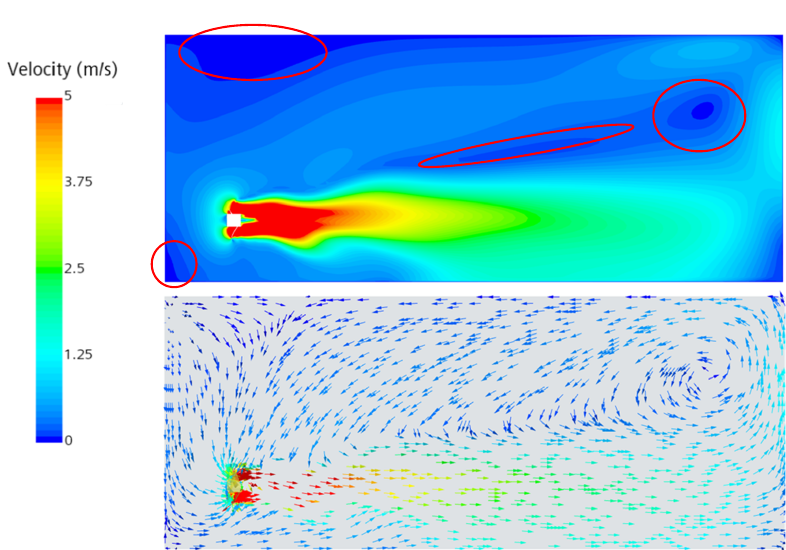
Figure 6. The distribution of the dead zone.